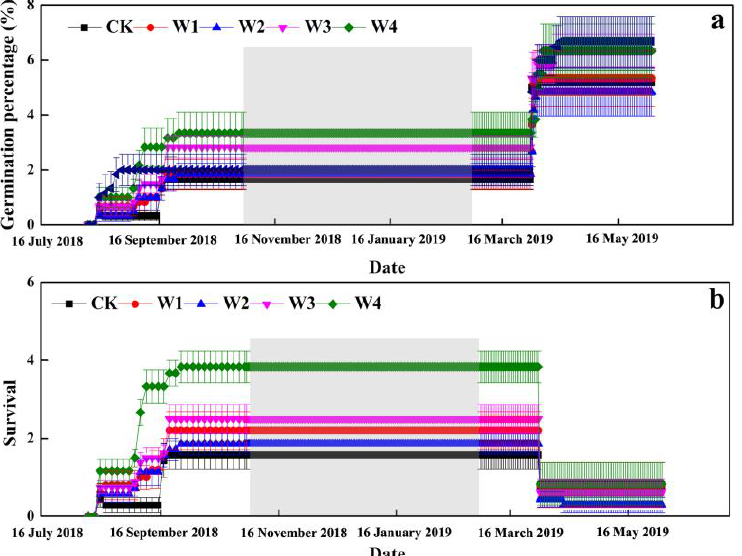
Figure 1. Effects of extreme precipitation on the seedling emergence ( a ) and survival percentage ( b ) of Erodium oxyrhynchum . CK, control treatment; W1, +30% extreme precipitation; W2, +100% extreme precipitation; W3, +200% extreme precipitation; W4, maintenance of field capacity by increasing precipitation every three days; Shaded part indicates snowfall in winter and observations were missing. Table 1. Effects of extreme precipitation on phenology of SG and AG plants of Erodium oxyrhynchum .